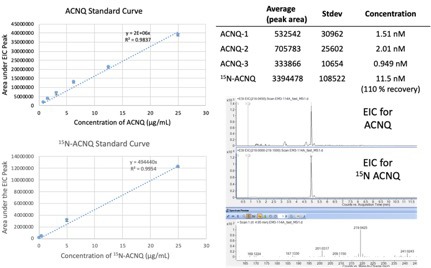
Absolute quantification of ACNQ in MR-1 culture using 15N-ACNQ as an internal standard to determine recovery yields.Standard curves were generated using 4-point calibration curves with biological triplicates.